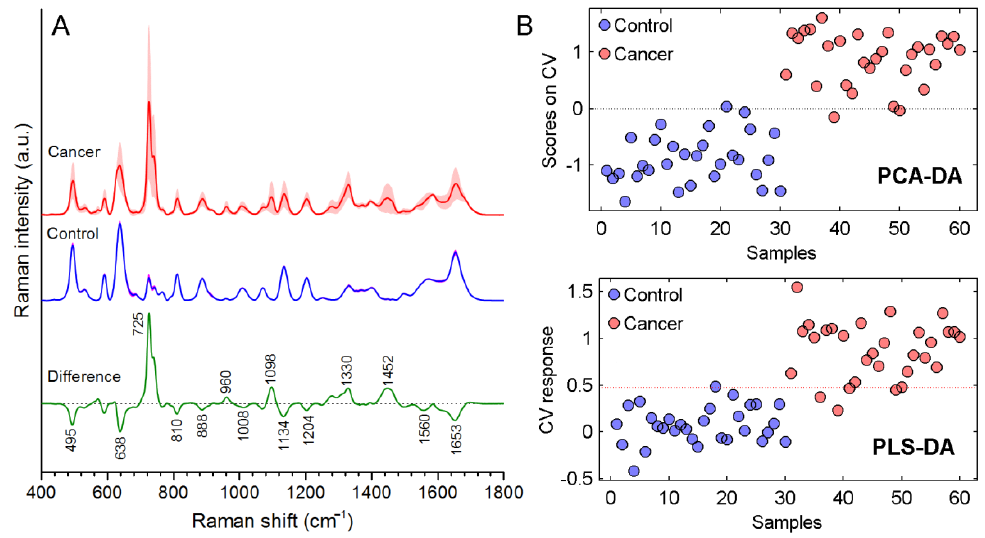
Figure 4. ( A ) SERS spectra of serum samples of cancer patients, of healthy subjects (control) and the difference spectrum of the two groups. ( B ) PCA-DA and PLS-DA scores of each spectrum. Further data analysis was performed using multivariate statistical analysis